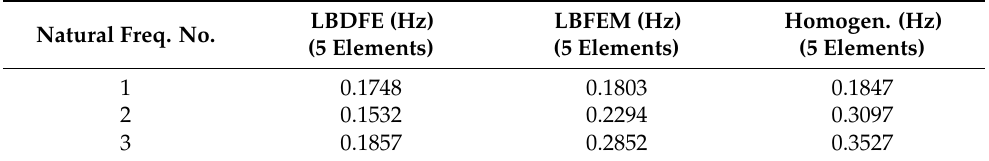
Table 2. The relative errors of LBDFE, LBFEM and homogenization methods with respect to experi- mental results